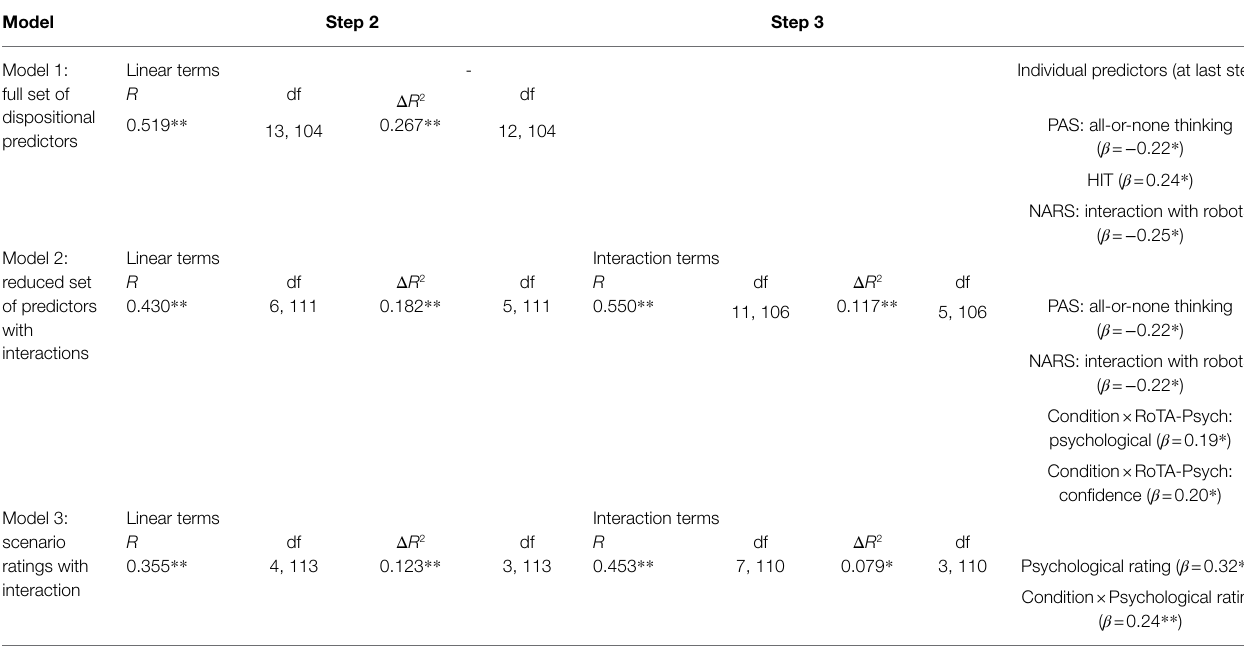
TABLE 5 | Regression statistics for three models for prediction of situational trust. Model Step 2 Step